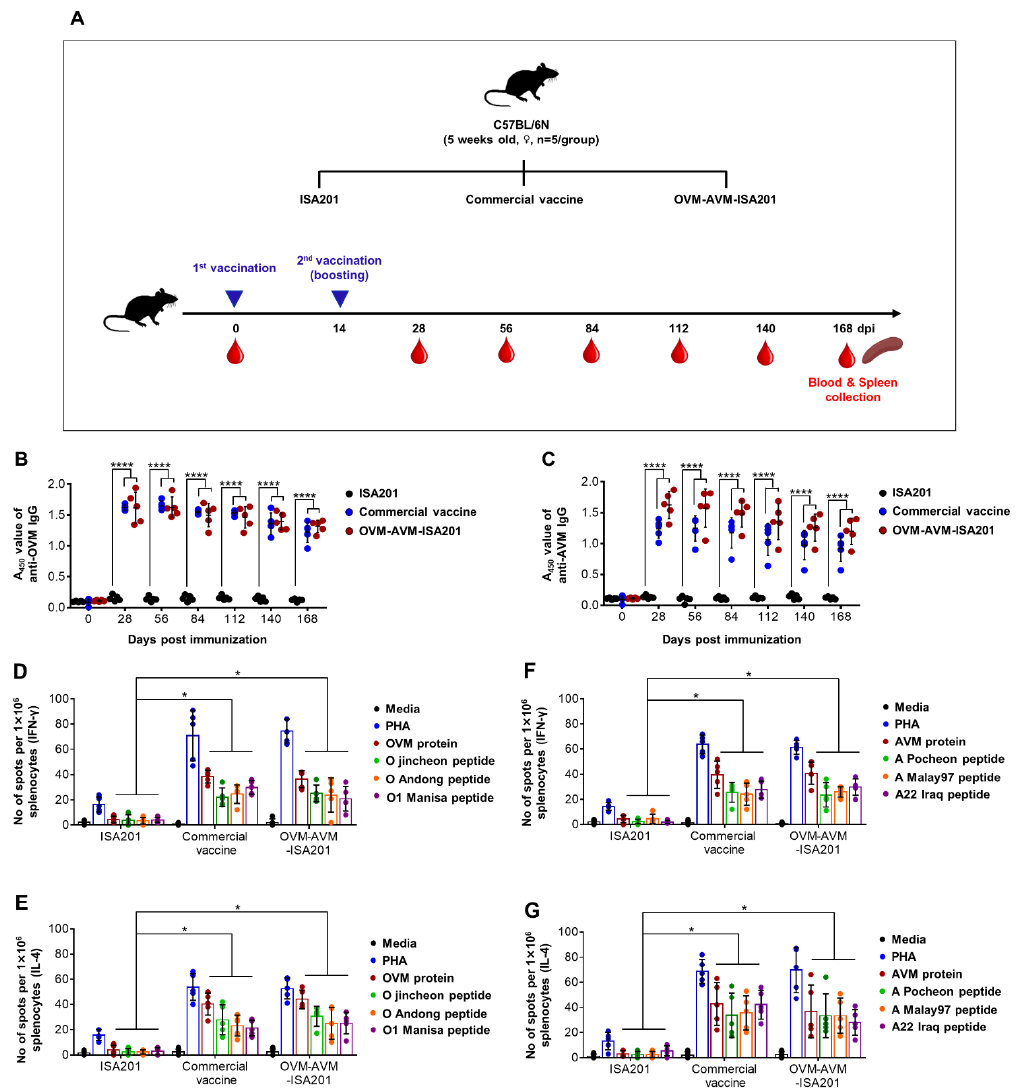
Figure 4. OVM-AVM-ISA201 induced long-lasting immunity in mice. As the strategy depicted in Figure 4A, mice ( n = 5/group) were intramuscularly administered with 20 µ g of OVM and 20 µ g of AVM emulsified with ISA201. The positive control received (1/10 pig dose) commercial trivalent vaccine. The negative control received the same volume of ISA201. Vaccination was performed twice at 0 and 14 days. Blood samples were collected from the retro-orbital plexus on 0, 28, 56, 84, 112, 140, and 168 days post immunization (dpi) and serum was used for serological analysis. At 168 dpi, spleens were harvested for splenocyte isolation for CTL response evaluation. ( A ) Schematic depiction of mouse experiment strategy. ( B ) OVM-specific total IgG titers. ( C ) AVM-specific total IgG titers were determined by indirect ELISA. ( D , F ) Antigen-specific IFN- γ spot forming cells . ( E , G ) Antigen-specific IL-4 spot forming cells were enumerated by ELISPOT. PHA: Phytohaemagglutinin. The values are presented as mean ± SE. Statistical analyses were performed using two-way ANOVA with Dunnett’s multiple comparisons test. * p < 0.05, **** p < 0.0001.